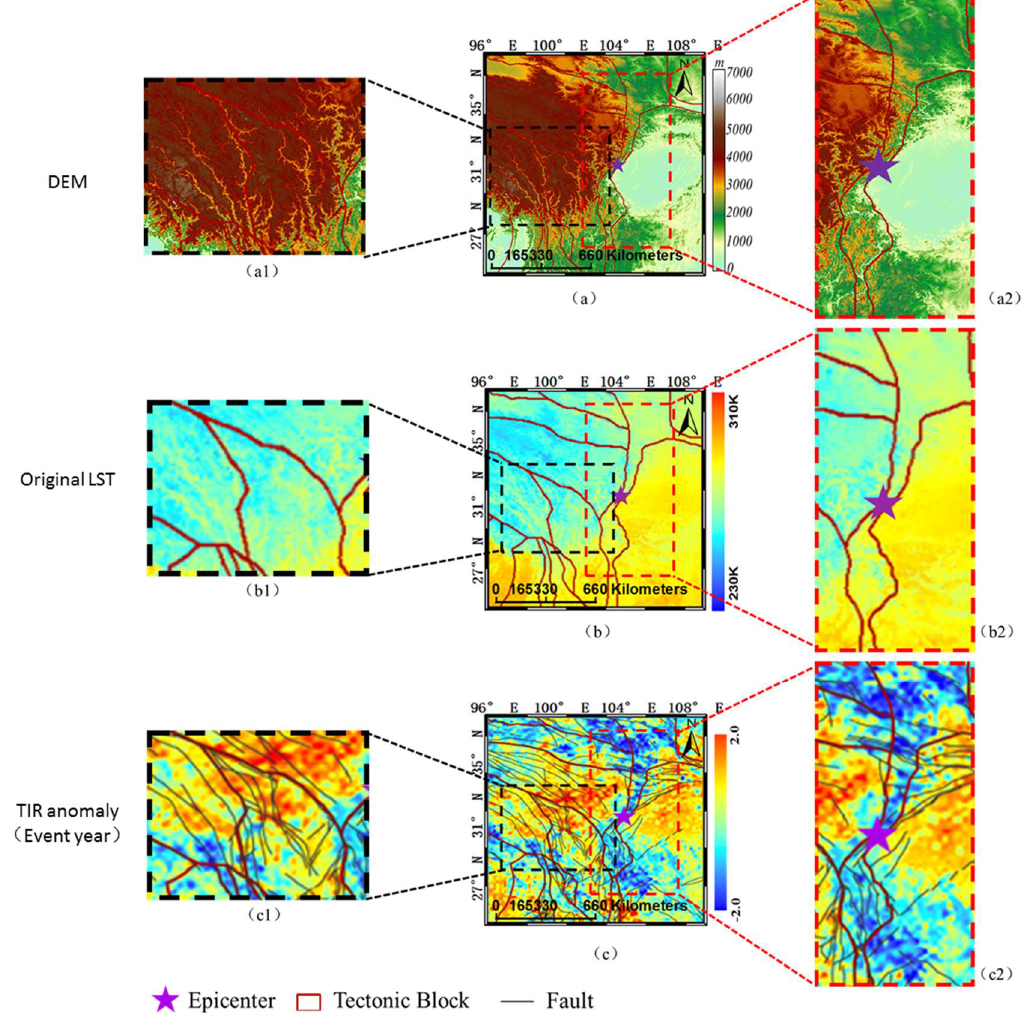
Figure 22. Presentation of the DEM, original MODIS LST data, and TIR anomalies bases on the TTIA method in Ms 8.0 Wenchuan earthquake event area.